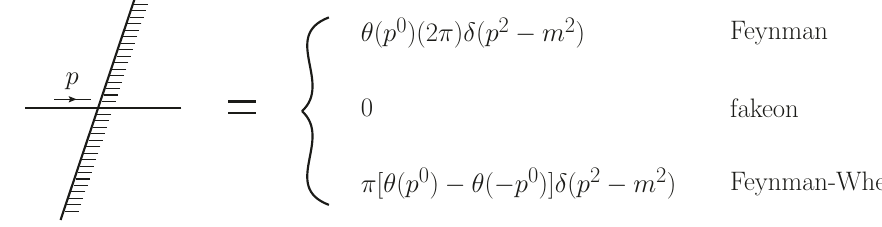
2 i times the bubble diagram. (cid:0)